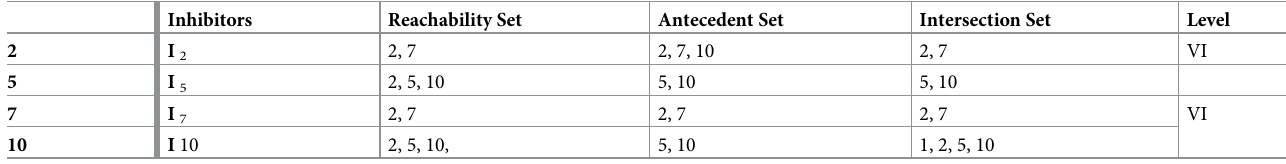
Table 12. Level partitioning iteration-6.